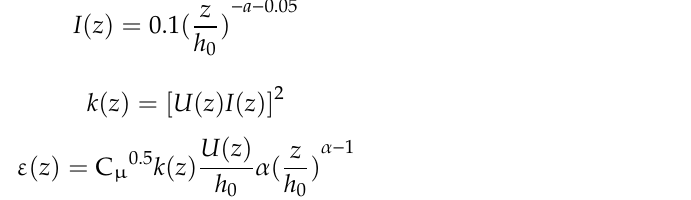
Figure 7. Grid resolution for the reference case: ( a ) global grid resolution; ( b ) grid resolution around the building and louvers.